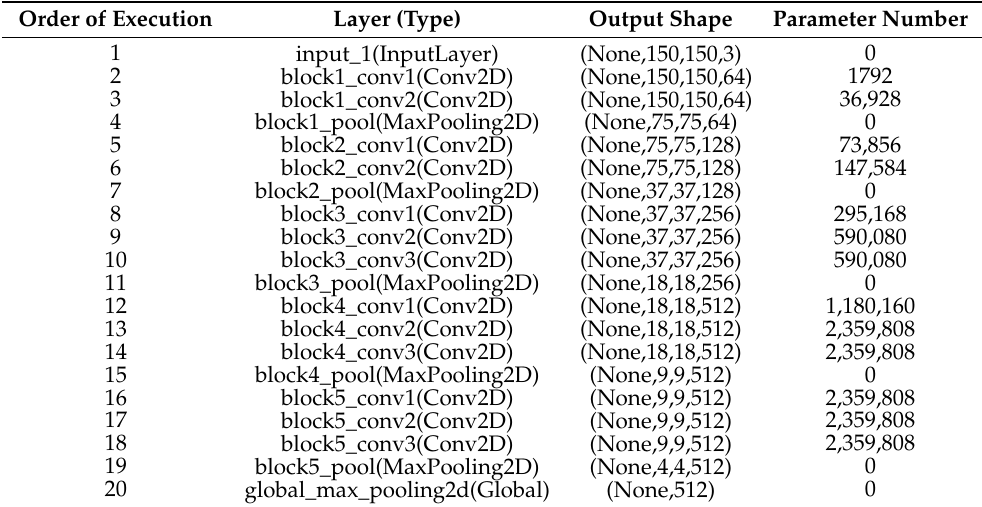
Table 2. Architecture of the base convolutional neural network (CNN) used with the shapes and numbers of hyperparameters, sorted by the order of execution.